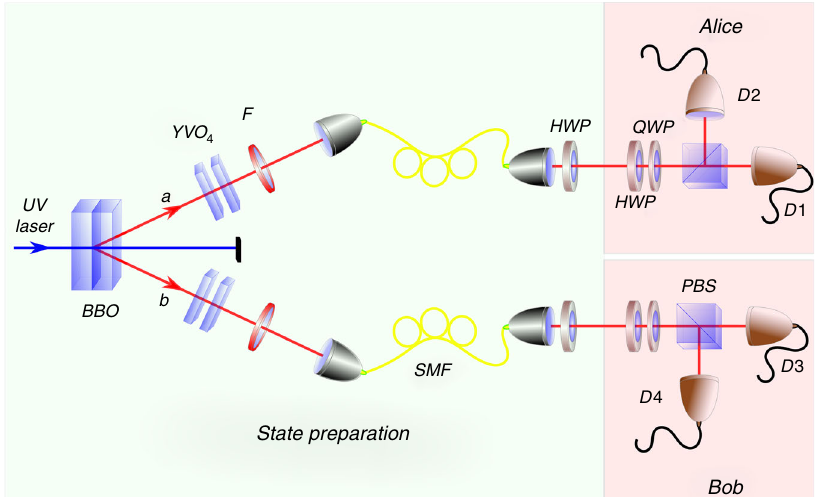
Fig. 3 Preparation and measurement stages. A UV pump laser at 390 nm was focused onto two β -barium borate (BBO) crystals placed in cross- con fi guration to produce photon pairs emitted into two spatial modes “ a ” and “ b ” through type-I SPDC process. Any spatial, temporal or spectral distinguishability between the photons is removed via a pair of YVO 4 crystals, narrow-bandwidth fi lters (F), and coupling into single-mode fi bers (SMF). Then, the photons in each mode are rotated through a half waveplate to get the desired state Eq. (10). For measurement, Alice and Bob uses polarization analyzers consisting of a half waveplate (HWP), a quarter waveplates (QWP), a polarizing beam splitter (PBS) and D i ( i = {1, 2, 3, 4}) single-photon avalanche photodiodes